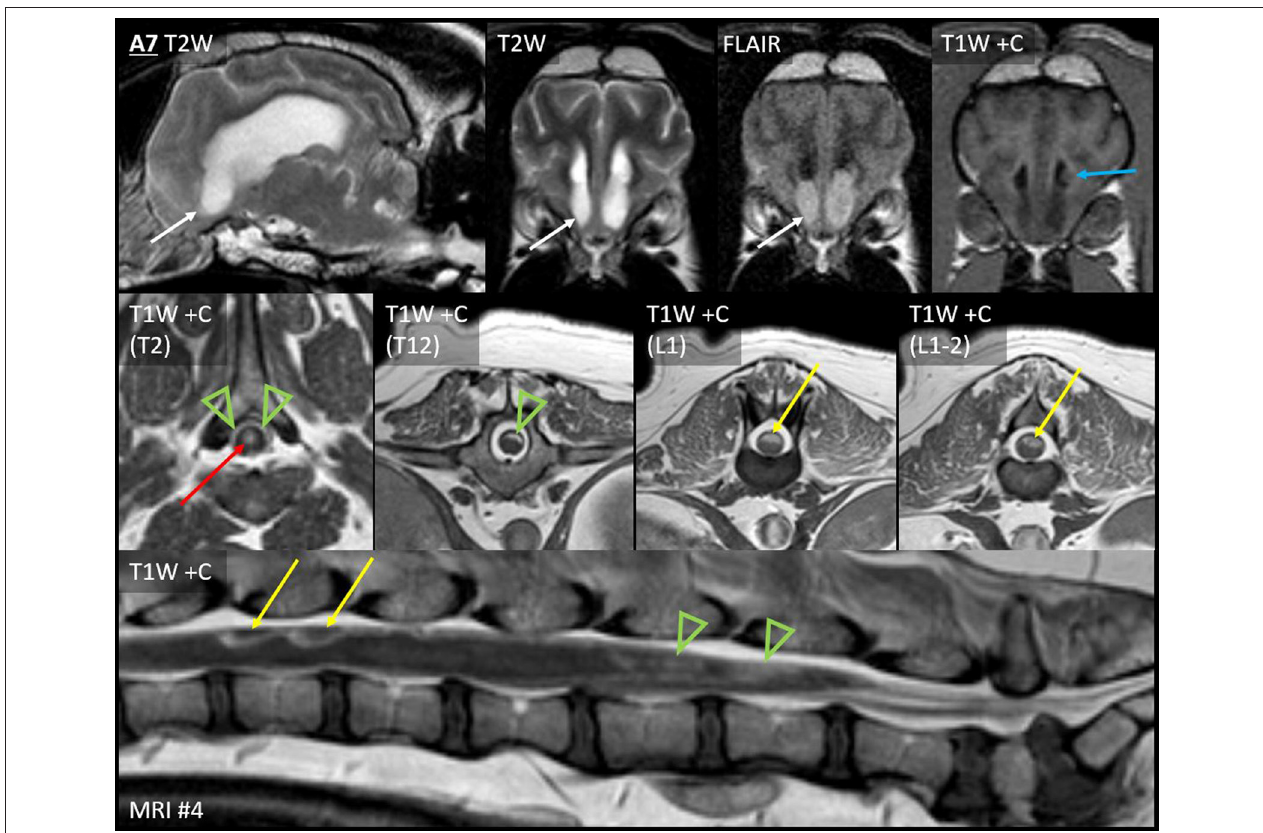
FIGURE 5 | Leptomeningeal dissemination (nodular type Ia and diffuse type Ib) and subependymal dissemination (type II), Case A7. Seven months after CED for a parietal lobe mass, Case A7 developed paraparesis. Top row: Parasagittal T2W and transverse T2W, T2W-FLAIR and T1W post-contrast images of the rostral horns. Middle row: T1W post-contrast transverse images at the level of the T2, T12, L1, and L1–L2 vertebrae. Bottom row: T1W post-contrast sagittal image of the lumbosacral vertebrae. Abnormal material fills the ventral aspect of both rostral horns (white arrows). Material is nearly T2-isointense to adjacent CSF but is distinctly hyperintense to CSF on FLAIR. The material is non-contrast-enhancing; an enhancing ependymal nodule is located just dorsally within the left ventricle (blue arrow). This accompanied irregular thickening and enhancement (green arrowheads) of the dorsal leptomeninges from T1 to L4, the conus medullaris, and the accompanying nerve roots. There were also four distinct nodules: two are shown (L1 and L1–L2, yellow arrows). Central canal ependymal enhancement was present at T2–T4 (red